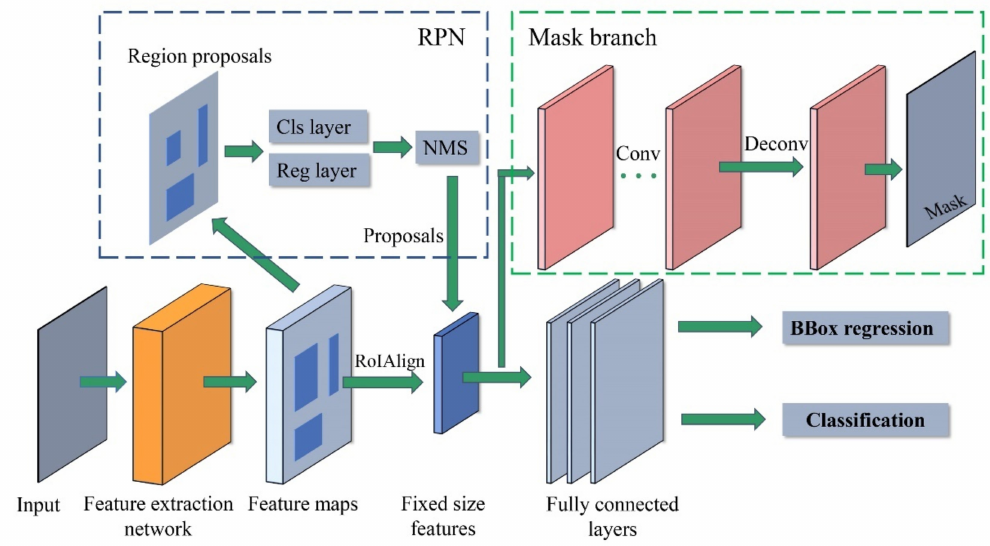
Figure 4. The schematic architecture of Mask R-CNN. “Cls layer” denotes classification layer, “Reg layer” denotes regression layer, “Conv” denotes convolution operation, and “Deconv” denotes deconvolution operation, “NMS” denotes non-maximum suppression, “BBox regression” denotes bounding box regression, “RoIAlign” denotes region of interest align. RPN: region proposal